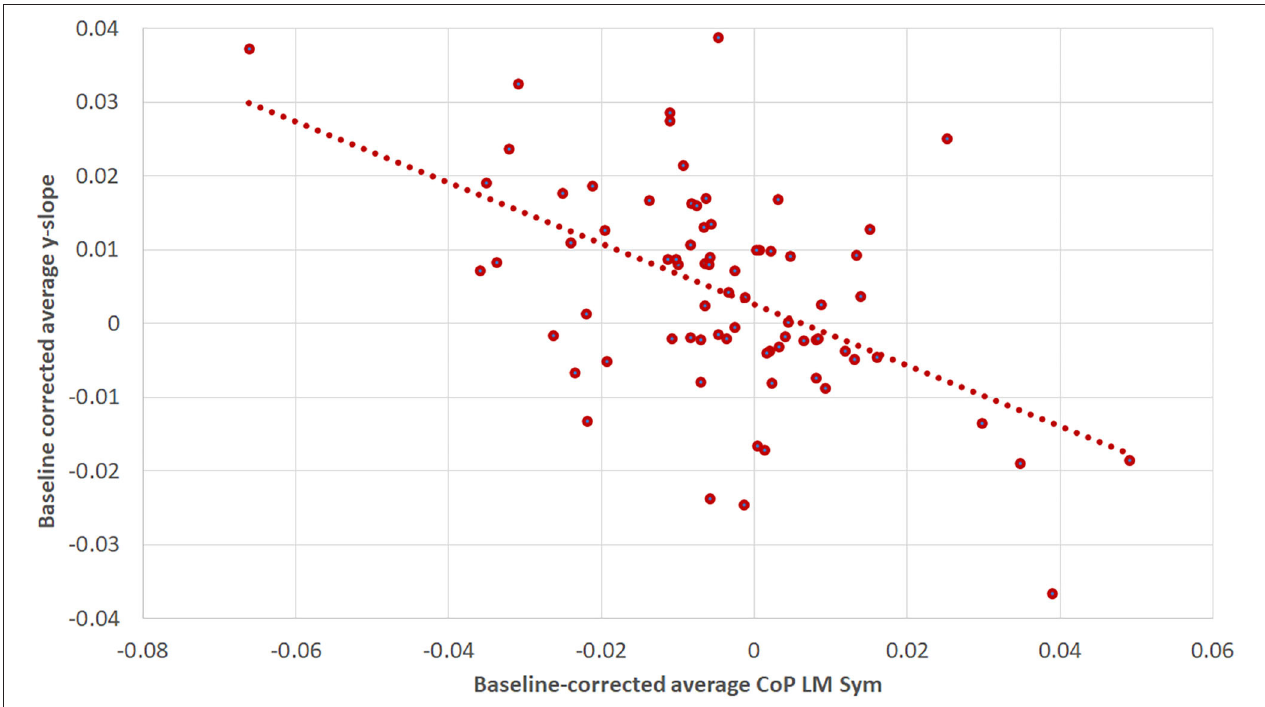
FIGURE 9 | The correlation between baseline-corrected average yaw slope and baseline-corrected average CoP LM Sym for the first WS. The Pearson correlation coefficient was R = − 0.518 ( p < 0.001). The figure is composed of three data points per subject: one for the supine, one for the RED and one for the LED condition.